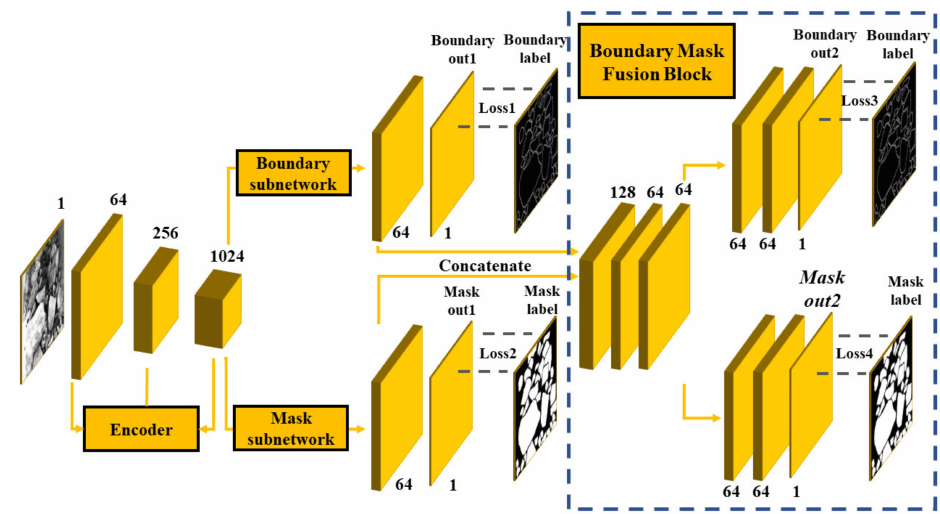
Figure 5. Simplified network structure and the detailed boundary mask fusion block